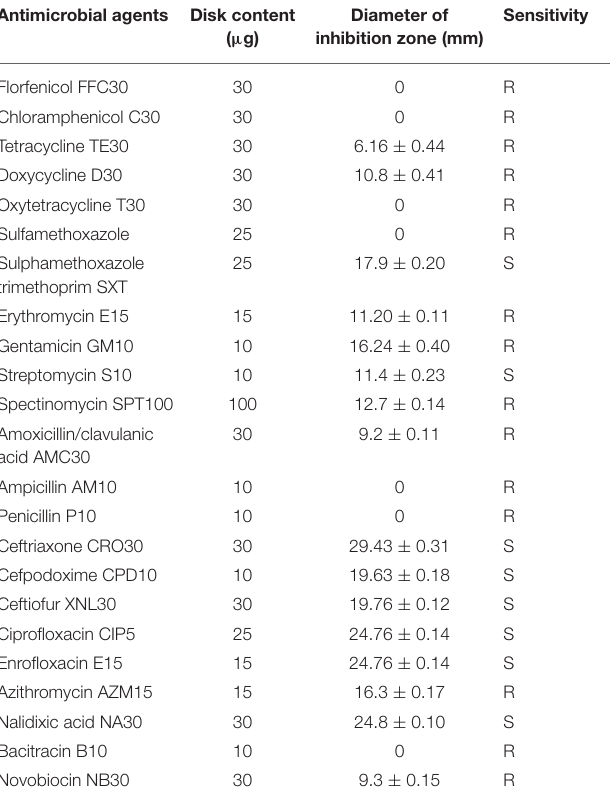
TABLE 3 | Antimicrobial resistance phenotype of A. veronii strain MS-17-88. Antimicrobial agents Disk content Diameter of ( µ g) inhibition zone (mm)